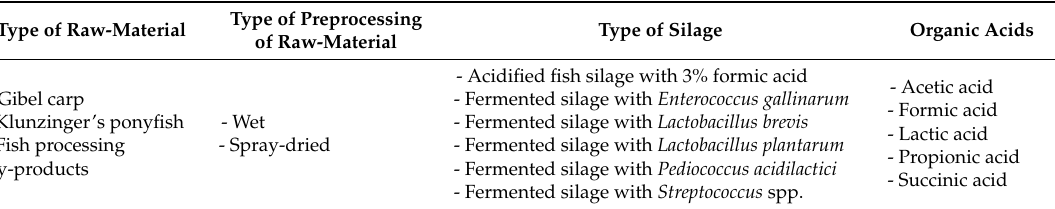
Table 1. Overall experimental